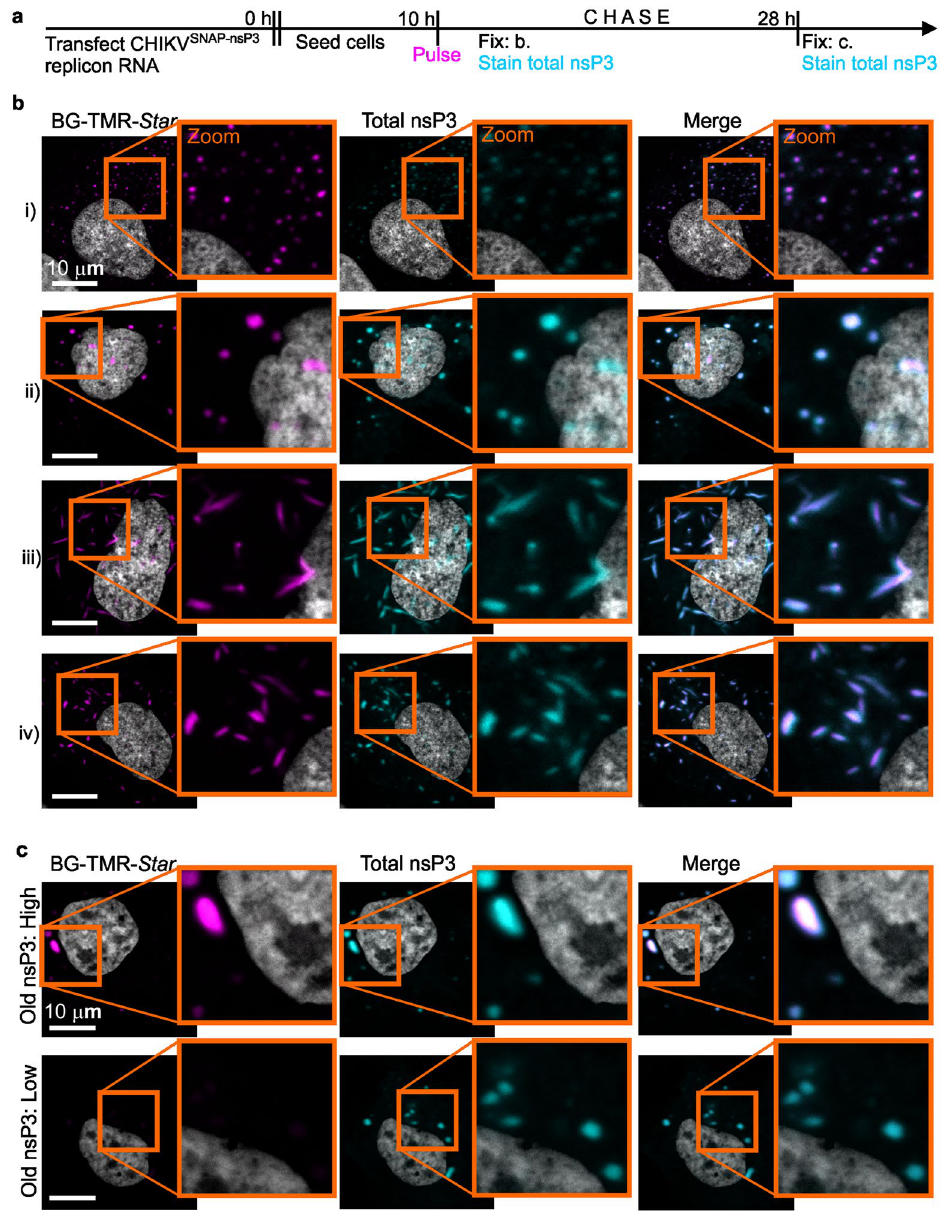
Figure 5. The appearance of SNAP-nsP3-positive structures is time-dependent and transient. ( a ) HuH-7 cells were transfected with CHIKV SNAP-nsP3 RNA and incubated with BG-TMR- Star (pulse) ten hours after transfection, turning the available pool of SNAP-nsP3 fluorescent. After washout of the substrate (chase), cells continued to synthesise SNAP-nsP3, which was not labelled, while the pulsed pool turned over. The remaining fluorescently labelled pool of SNAP-nsP3 was visualised after an 18-h chase by confocal microscopy. The total pool of nsP3 was detected with nsP3-specific antiserum. Data was acquired with a Zeiss LSM 880 confocal system with Airyscan, operated in the confocal mode with a Plan-Apochromat 63x oil objective (1.4 numerical aperture). ( b ) Images from pulse-chase experiment show cells fixed immediately following the pulse ten hours after transfection. Cells with the two main classes of nsP3 distributions, granules (i and ii) and rod-like structures (iii and iv) are shown. Insets are enlargements that show an overlap between SNAP-specific signal (pink) and antibody-specific signal (cyan). ( c ) Images from pulse-chase experiment show cells fixed after a pulse at ten hours after transfection, a chase media lacking BG-TMR- Star for 18 h, chemical fixation, and immunostaining for total nsP3. Cells were classified based on the level of BG-TMR- Star staining, which was high in some cells (upper panel) and low in others (lower panel). Representative cells are shown. Zoomed-in views of cells with a high level of SNAP-specific signal (pink) revealed that the signal from the total pool of nsP3 (cyan) co-localised. Zoomed-in views of cells with a low level of SNAP-specific signal (pink) indicated that the staining of total nsP3 (cyan) was present at a high level in the same structures, whereas the SNAP-specific signal was low but still detectable. Cells were counterstained with DAPI (grey) to visualise